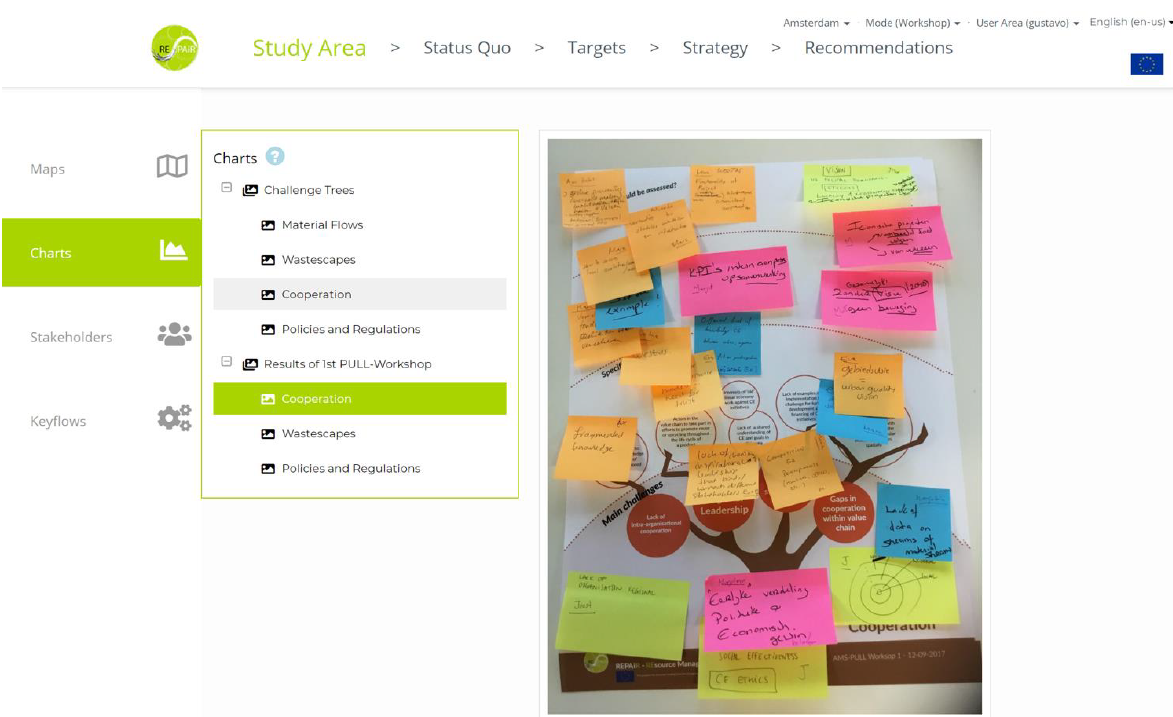
Figure 8. The use of the GDSE helped stakeholders describe the focus area based on particular topics. The CE challenges in the AMA were overlaid with feedback from participants of the co-exploration workshop, were then are uploaded to the